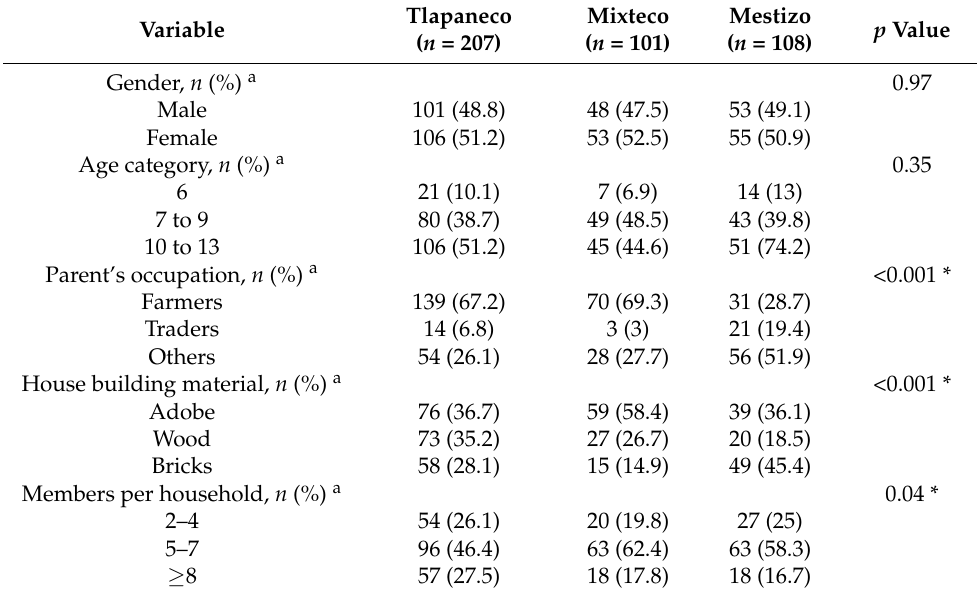
Table 2. Demographic characteristics of the study sample according to ethnic group.